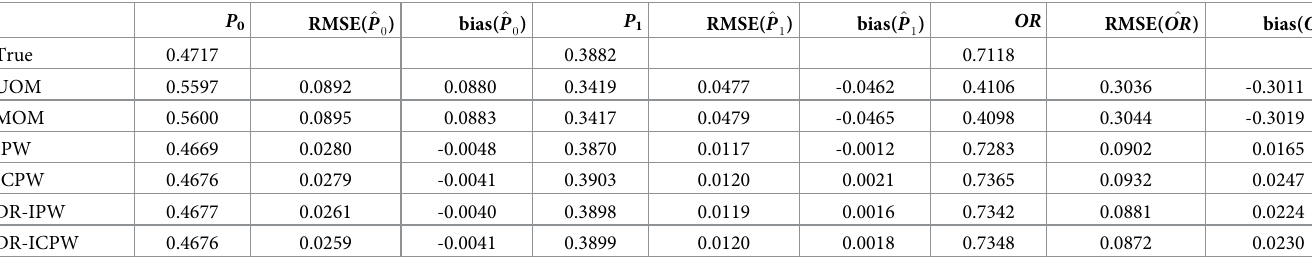
Table 6. Result of scenario 2, a balanced number of animals per feedlot